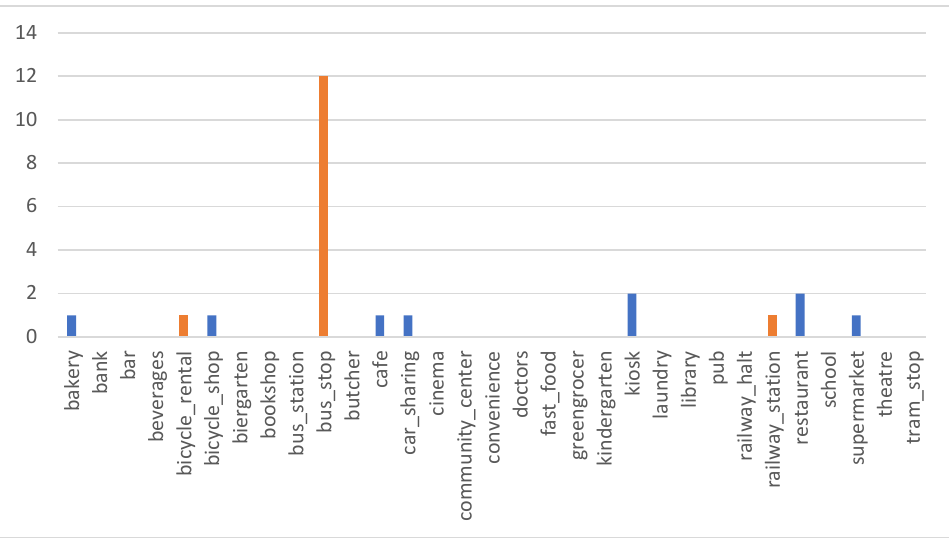
Figure 15. Number of POIs in the vicinity of 500 m in the surrounding of the office location Die- selstraße in Unterföhring, Munich.